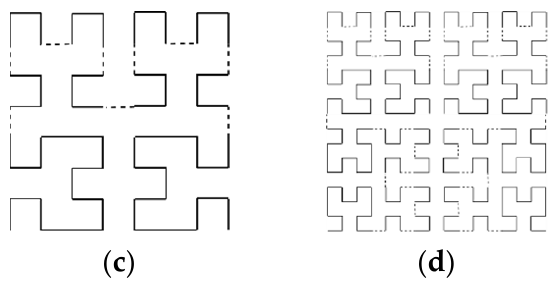
Figure 5. Iterative orders of Hilbert fractal curve: ( a ) first; ( b ) second; ( c ) third; ( d ) Forth.